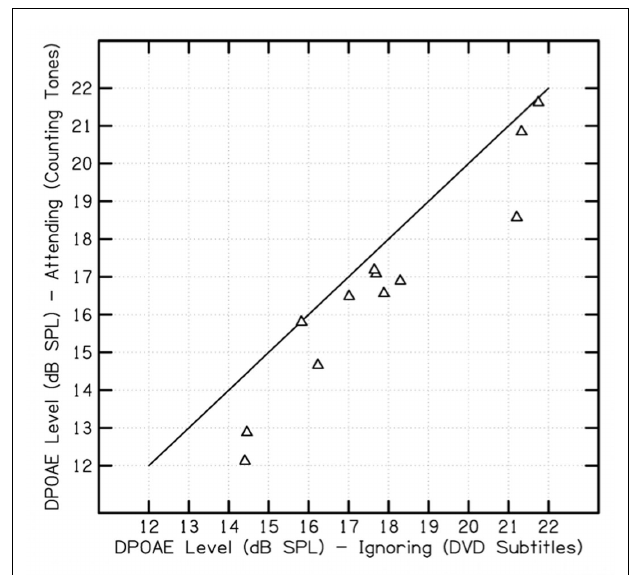
FIGURE 4 | Scatter plot comparison of absolute DPOAE levels recorded from individual participants during auditory-attending (counting tones) and auditory-ignoring conditions (watching muted DVD, reading subtitles) conditions in Experiment